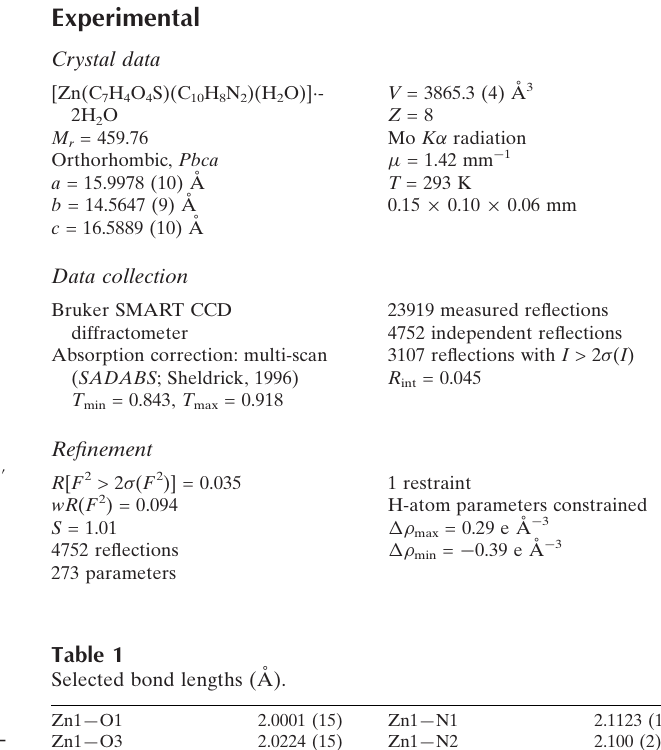
bipyramidal coordination geometry completed by two N